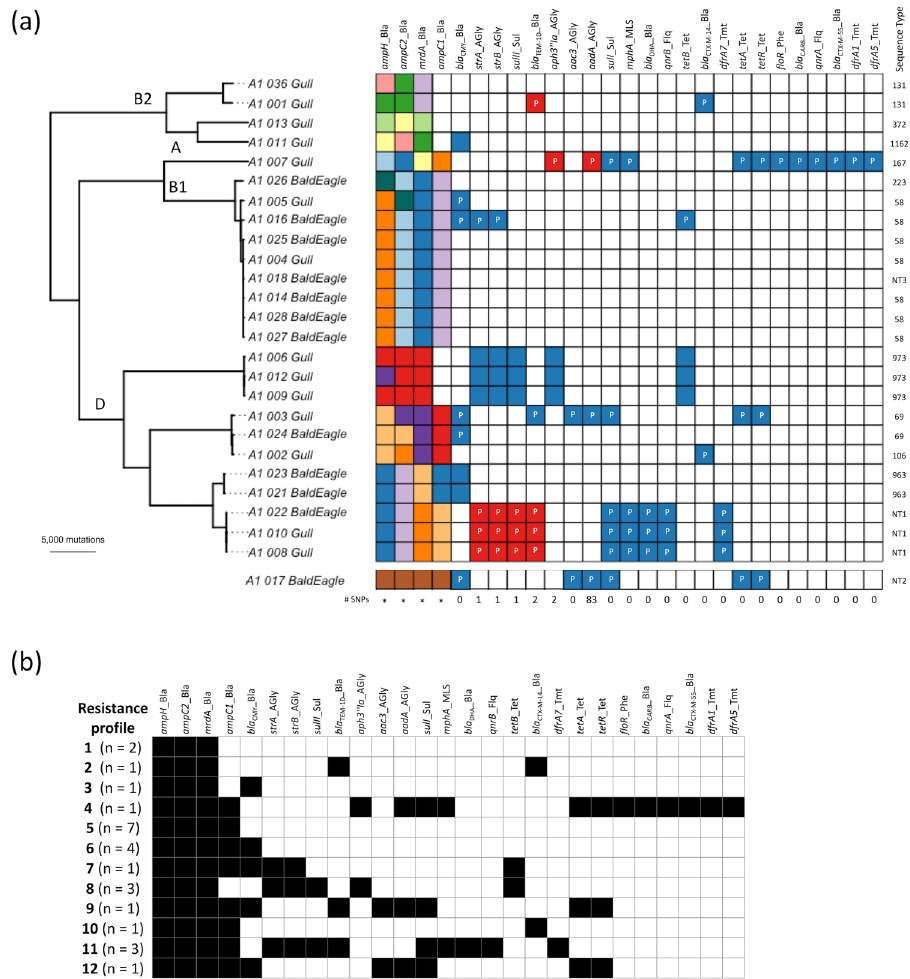
Figure 2. ( a ) Midpoint rooted clonal core genome phylogeny of 25 cephalosporin-resistant E . coli isolates originating from gulls and bald eagles in Alaska. Phylotypes (A, B1, B2, D) are indicated on branches. Presence of each of 27 identified AMR genes is shown as a matrix, with gene names indicated at the top of the matrix underscored by the antibiotics class (AGly: aminoglycosides, Bla: beta-lactamases, Flq: fluoroquinolones, MLS: macrolide-lincosamide-streptogramin, Phe: phenicols, Sul: sulfonamides, Tet: tetracyclines and Tmt: trimethoprim). Coloured squares indicate presence and white indicates that the gene was not found. Each colour indicates a different allele for each gene. The number of SNPs differentiating AMR genes with two alleles is shown below the matrix, while the phylogenetic diversity of genes with more than two alleles (indicated by * ) can be seen in Fig. 3. AMR genes found on plasmids identified by PlasmidSPAdes are indicated with the letter “P”. The final column of the matrix indicates in silico identified E . coli sequence types. The divergent A1_017_BaldEagle isolate is included at the bottom of the matrix, as it was omitted from the midpoint rooted clonal core genome phylogeny. (b) Unique resistance profiles identified through in silico AMR gene detection in cephalosporin-resistant E . coli isolates. A presence/absence matrix of 27 identified AMR genes is shown, with black shading indicating presence, and no shading indicating that the gene was not found. The number of isolates found with each resistance profile is indicated in